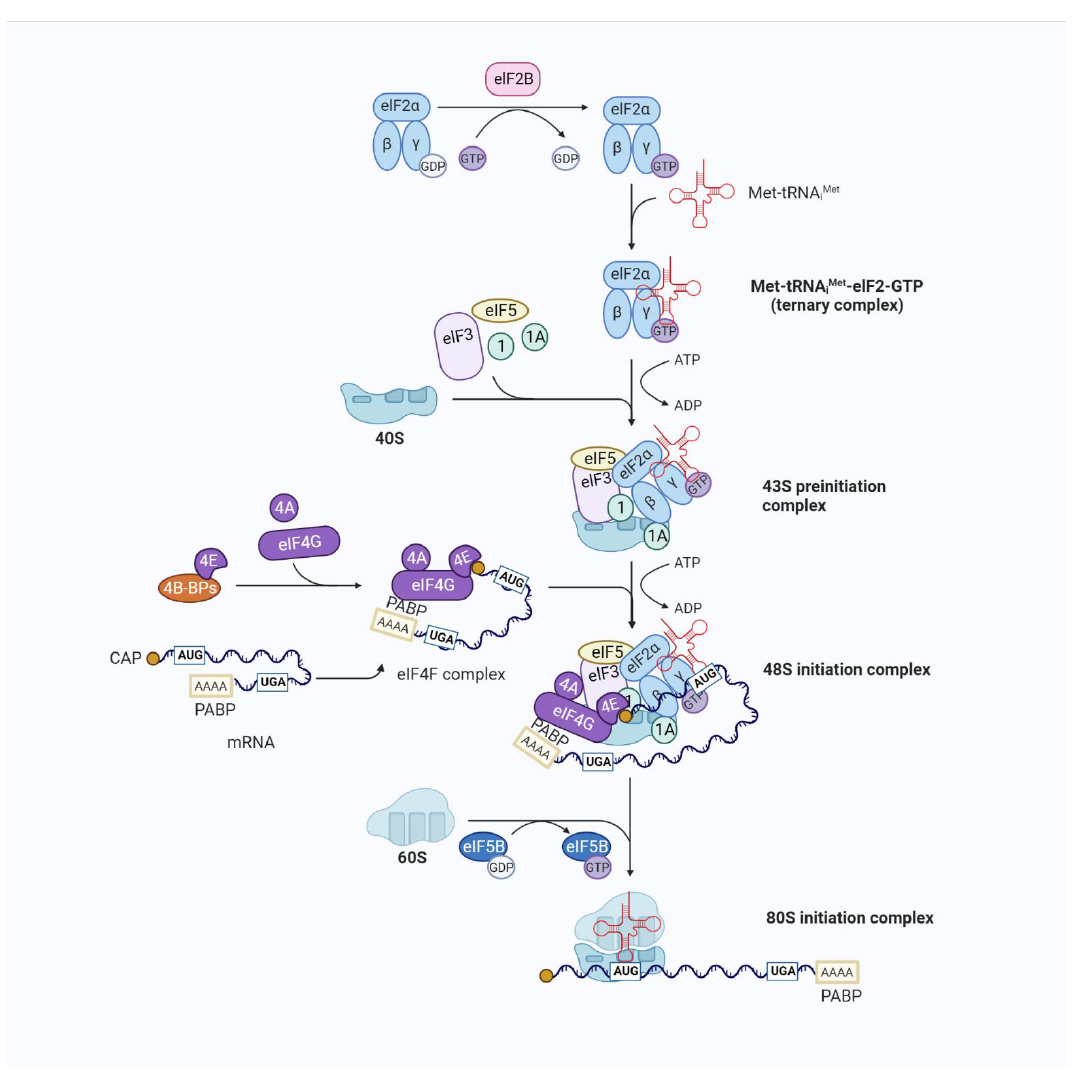
Figure 2. Overview of eukaryotic translation initiation. Translation is an iterative process. The typical mechanism for the regulation of translation occurs at the rate-limiting stage of initiation, starting with the formation of the EIF2/GTP/Met-tRNA iMet TC and involving the control of the functional 40S subunit and its related factors (the 43S preinitiation complex (43S PIC)) assembly. The 43S PIC is a large complex formed by the binding of the 40S ribosomal subunit to the eukaryotic translation initiation factors eIF1, eIF1A, eIF3, and eIF5 and the TC. The recruitment of the 43S PIC to the mRNA template is facilitated by eIF4F, a complex consisting of the mRNA 5 (cid:48) -cap-binding subunit (eIF4E), a large scaffold protein (eIF4G), and an RNA helicase (eIF4A), resulting in the 48S PIC form. eIF4F recruits ribosomes to mRNA through the eIF4E-mRNA cap and eIF4G-eIF3 interaction to form the 48S initiation complex. eIF4G also interacts with poly(A)-binding protein (PABP), which binds to the mRNA 3 (cid:48) poly(A) tail, resulting in mRNA circularization to stabilize mRNA and facilitate translation. The eIF4A helicase, which unfolds structures near the mRNA 5 (cid:48) -cap with other stronger helicases (DHX29), is involved in the initial interaction of eIF4F with the 5 (cid:48) end of mRNA and can also facilitate the scanning of the 40S ribosomal subunit towards the start codon by resolving secondary structures in the 5 (cid:48) untranslated region (UTR). The recognition of the initiation codon by the 43S PIC results in the release of eIF and the joining of the 60S subunit. The formation of the translationally competent 80S ribosome marks the end of initiation and the beginning of